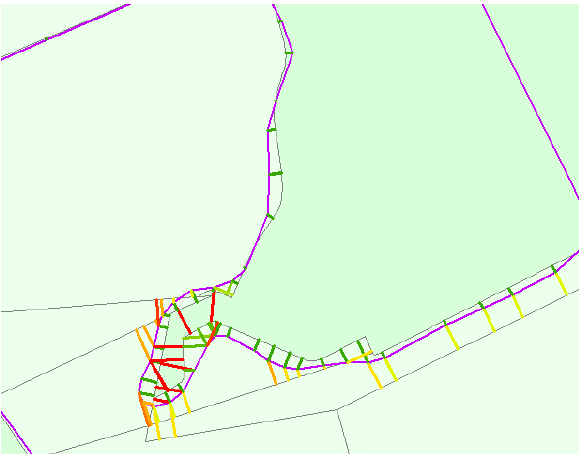
Figure 10. ALKIS (black) and ATKIS (purple) data overlay for a forest. Links with similarity indication (coloured lines) In the lower left part of the object, there are several red links which are indicating that the confidence in them is not very high. The reason is that the boundary line in ATKIS (purple) is